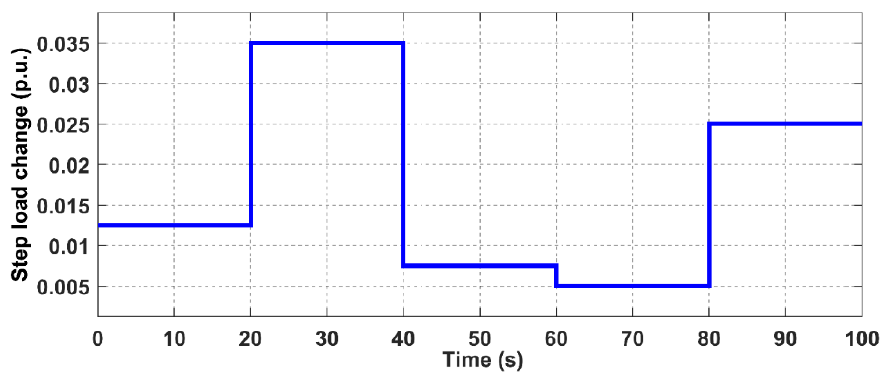
Figure 12. Random change load.